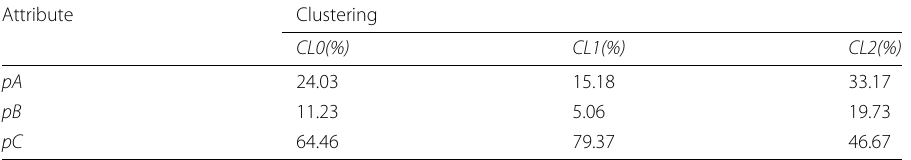
Table 3 Average distribution of interactions in each cluster Attribute Clustering CL0(%) CL1(%) CL2(%) pA 24.03 15.18 33.17 pB 11.23 5.06 19.73 pC 64.46 79.37